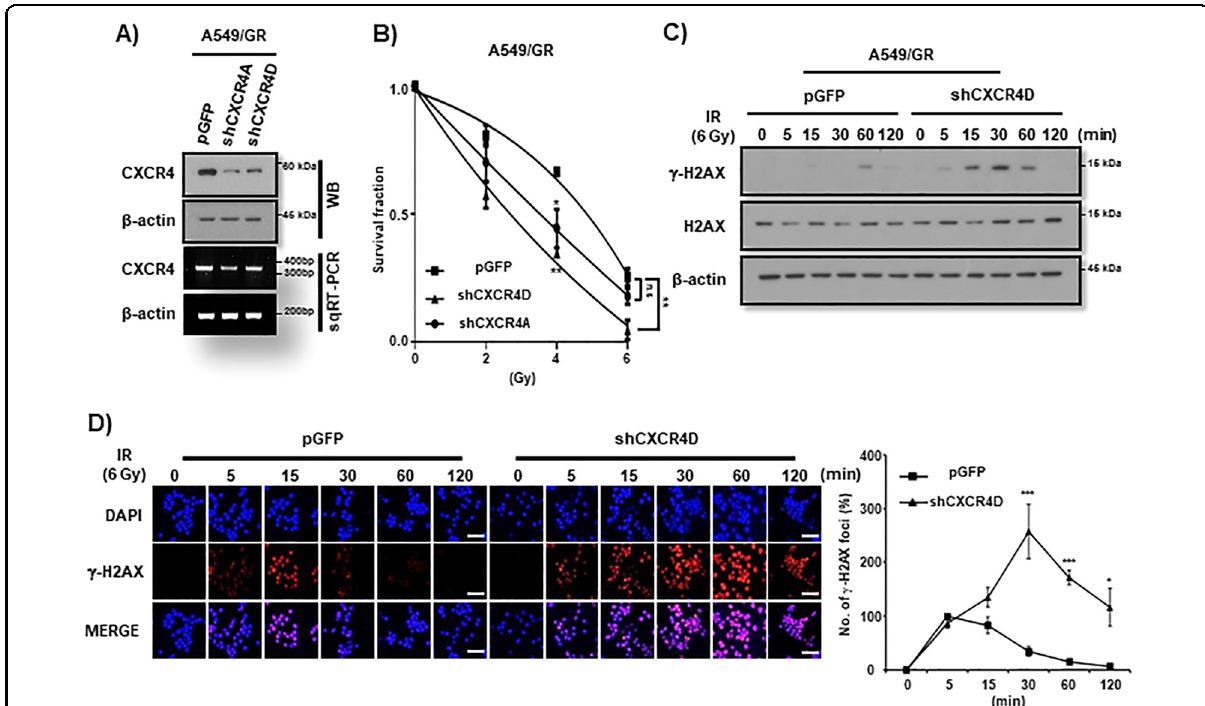
Fig. 2 Knockdown of CXCR4 decreases the survival of A549/GR cells to IR. A Western blot (WB, upper) and RT-PCR (lower) analysis of CXCR4 in A549/GR cells transfected with shControl (pGFP) or shCXCR4A and D. B IR clonogenic assay of A549/GR cells transfected with shCXCR4D. Cells (2.5 × 10 2 ) were exposed to IR at various doses described in the Figure. IR-exposed cells were evaluated colony-forming activity at 10 days after IR. * P < 0.05, ** P < 0.01, *** P < 0.005. C Western blot analysis of A549/GR cells exposed to IR at 6 Gy at the indicated time points transfected with shControl (pGFP) or shCXCR4D. D γ -H2AX foci assay of A549/GR cells. ICC was performed with the cells transfected with shControl (pGFP) or shCXCR4D using γ -H2AX antibody after exposing to IR (6 Gy) at the indicated time points. Representative immuno fl uorescence images of A549/GR cells (left) and quanti fi cation of the assay (right). Nuclei were counterstained with DAPI (blue). White bar: 20 μ